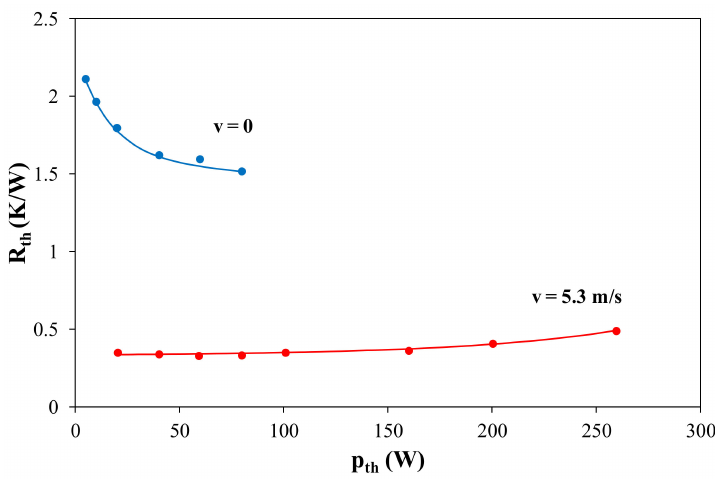
Figure 12. Measured and modelled dependences of the thermal resistance of the resistor mounted on the heat sink with a silicon paste on the dissipated power at selected values of the airflow speed (system